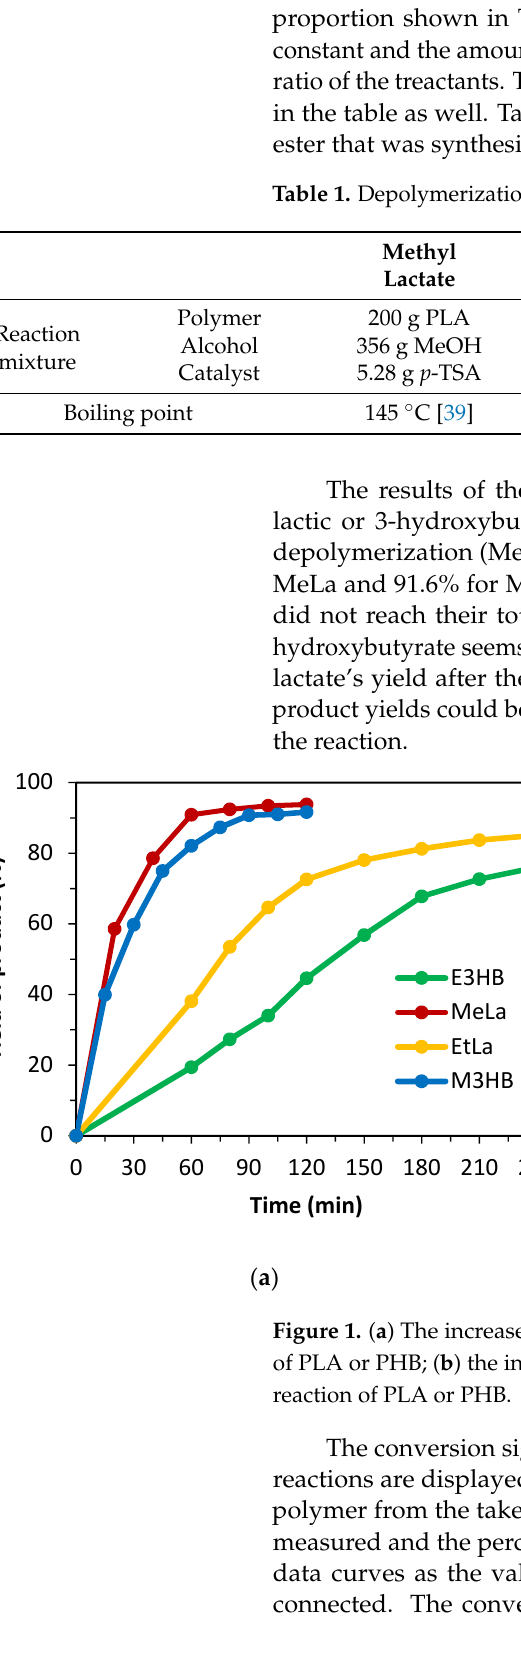
Figure 2. Pressure values dependence on time during depolymerization. 3.2. Kinetics of the Depolymerization of PLA and PHB via Alcoholysis The first-order reaction order is mostly used to describe the alcoholysis depolymer- ization due to the fact that if the excess of alcohol is added to the mixture, the concentra- tion of polymer molecules affects the reaction kinetics directly due to its lesser molar amount of mixture [43,44]. If the first-order reaction is used for the calculation, the equa- tions are the following: 𝑟 = 𝑑𝑐 (cid:3043)(cid:3042)(cid:3039)(cid:3052)(cid:3040)(cid:3032)(cid:3045) 𝑑𝑡